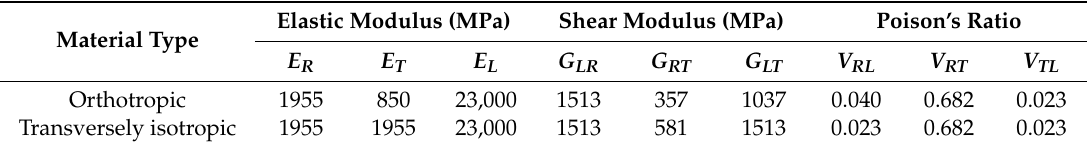
Table 1. Properties for orthotropic and transversely isotropic materials.